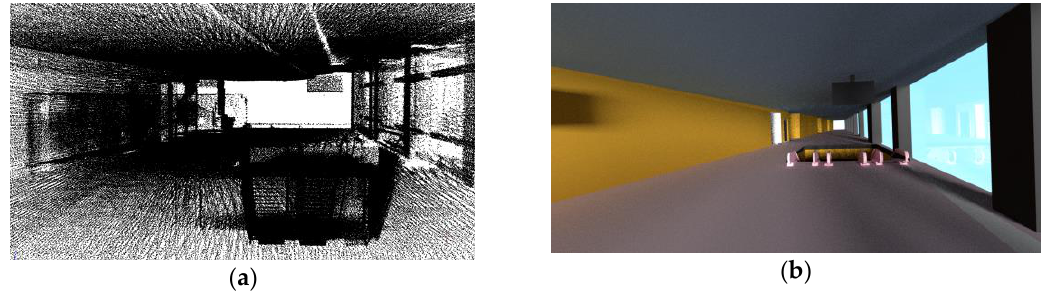
Figure 10. A 3D model of Quebec City Convention Centre, ( a ) 3D point cloud, and ( b ) 3D model.